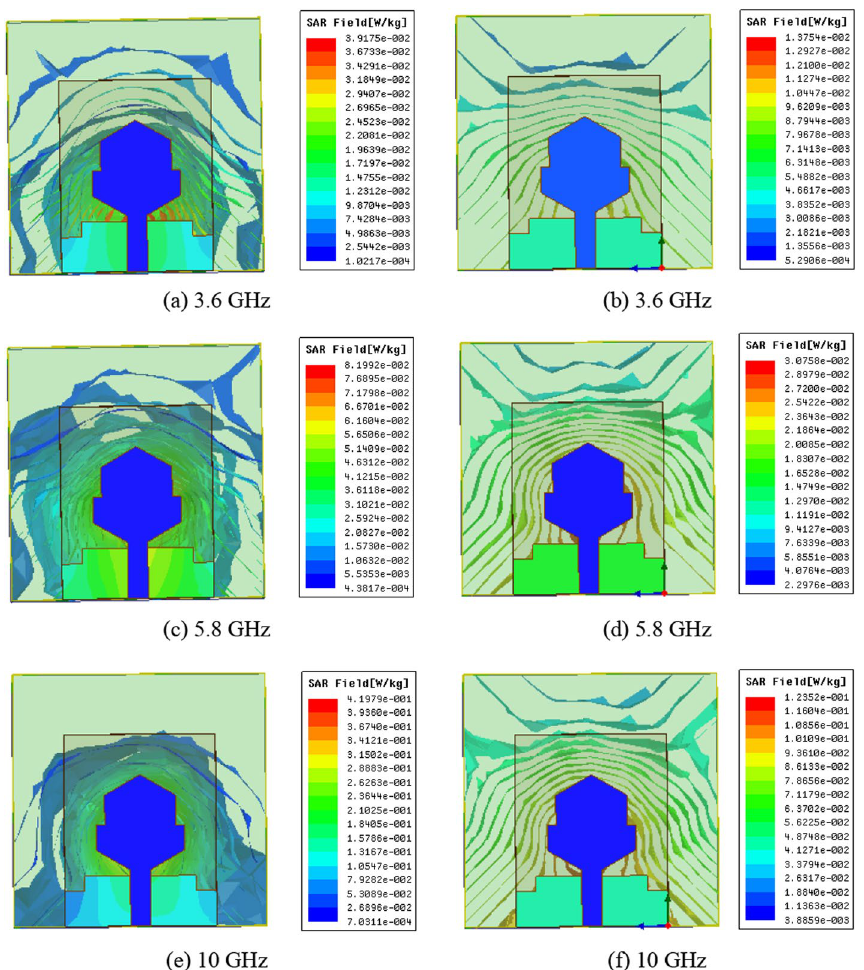
Fig. 13 SAR analysis of 1-g tissue ( a , c , e ) and 10-g tissue ( b , d , f ). The SAR is investigated over 1 g and 10 g of tissues for the input power of 1 mW at three different frequencies 3.6, 5.8, and 10 GHz. a , c , e show the SAR values over 1 g of tissue; on the other hand, b , d , f represent SAR values over 10 g of tissue. The average values of SAR obtained are 0.0391 W/kg, 0.0819 W/kg, and 0.419 W/kg for 1 g of tissue and 0.0137 W/kg, 0.0307 W/kg, and 0.123 W/kg for 10 g of tissues. The most significant aspect of the SAR is that, even if the frequency is increased to a high level, the SAR remained below the required safety